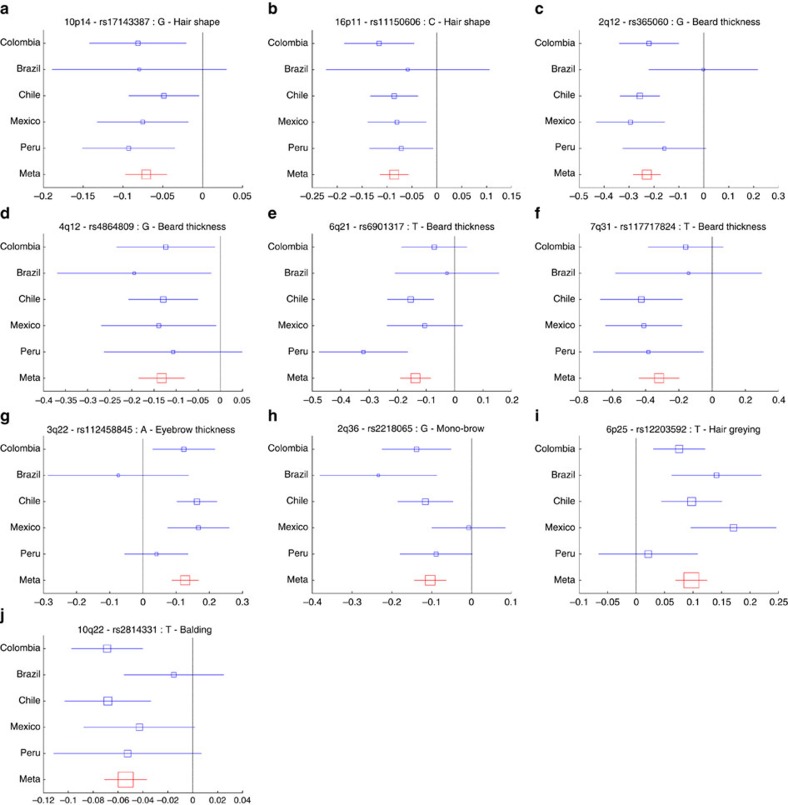
Effect sizes for the derived allele at index SNPs (Table 1) in ten genomic regions not previously associated with hair traits.(a) 10p14 hair shape, (b) 16p11 hair shape, (c) 2q12 beard thickness, (d) 4q12 bear thickness, (e) 6q12 beard thickness (f) 7q31 beard thickness (g) 3q22 eyebrow thickness, (h) 2q36 monobrow, (i) 6p25 hair greying, (j) 10q22 balding. Blue boxes represent regression coefficients (x axis) estimated in each country. Red boxes represent effect sizes estimated in the combined meta-analysis. Blue box sizes are proportional to sample size. Horizontal bars indicate a 95% confidence interval of width equal to 2 × standard errors. Meta-analysis P values are shown in Supplementary Table 4. Similar plots for regions previously associated with hair traits that were replicated here are shown in Supplementary Fig. 4.